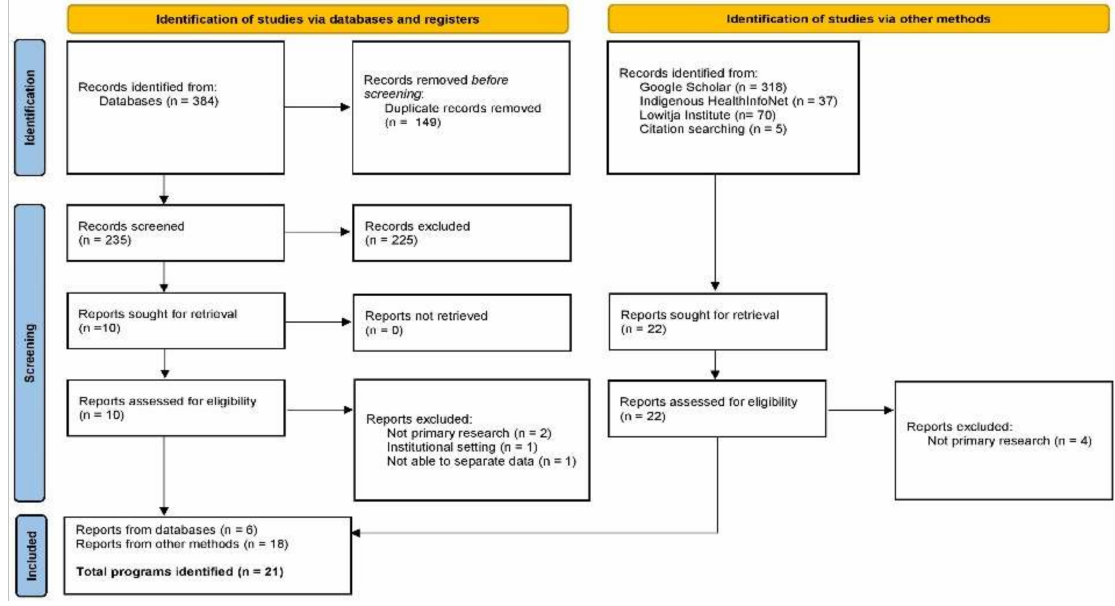
Figure 1. PRISMA Flow